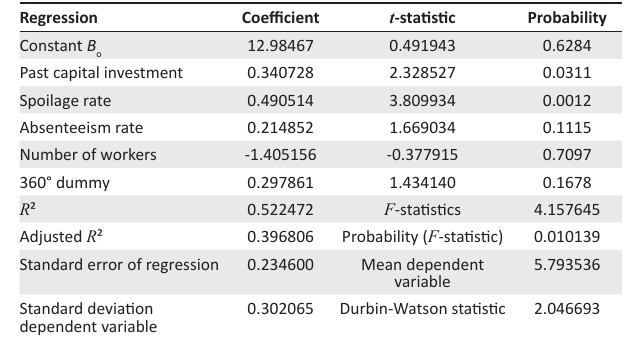
TABLE 3: Labour productivity results with past capital investment (lagged by one quarter) for spoilage and absenteeism rates, number of workers involved in production, and post 360-degree